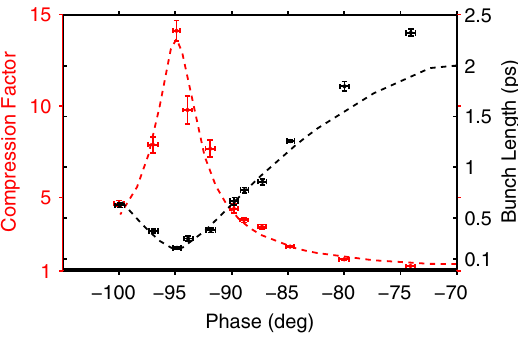
FIG. 3. Taken from [2]. Measurement of compression factor (red points) and rms bunch length (black points) as a function of the compression phase. The dashed lines are PARMELA simula- tion [34], both from compression factor (red lines) and bunch length (black